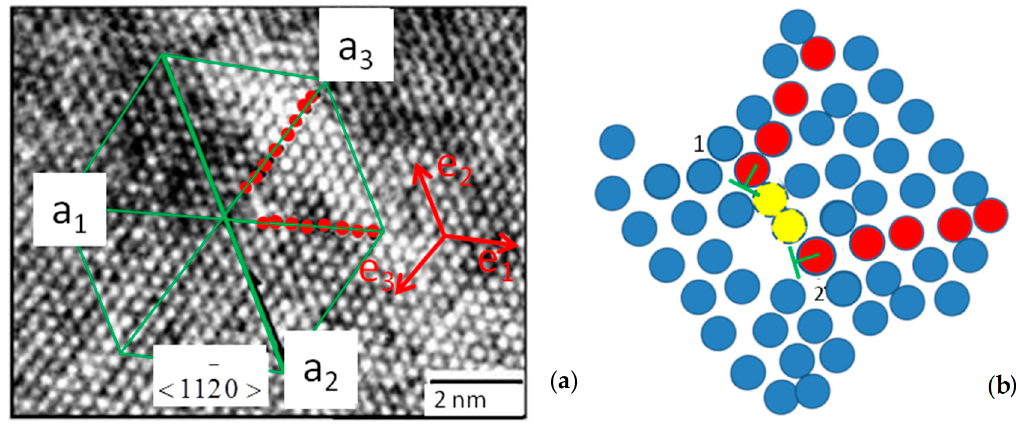
− − >< 0211 ≡ a 20 > ≡ a 2 ; ( b ) Schematic representation of atomic positions 2 ; ( b ) Schematic representation of